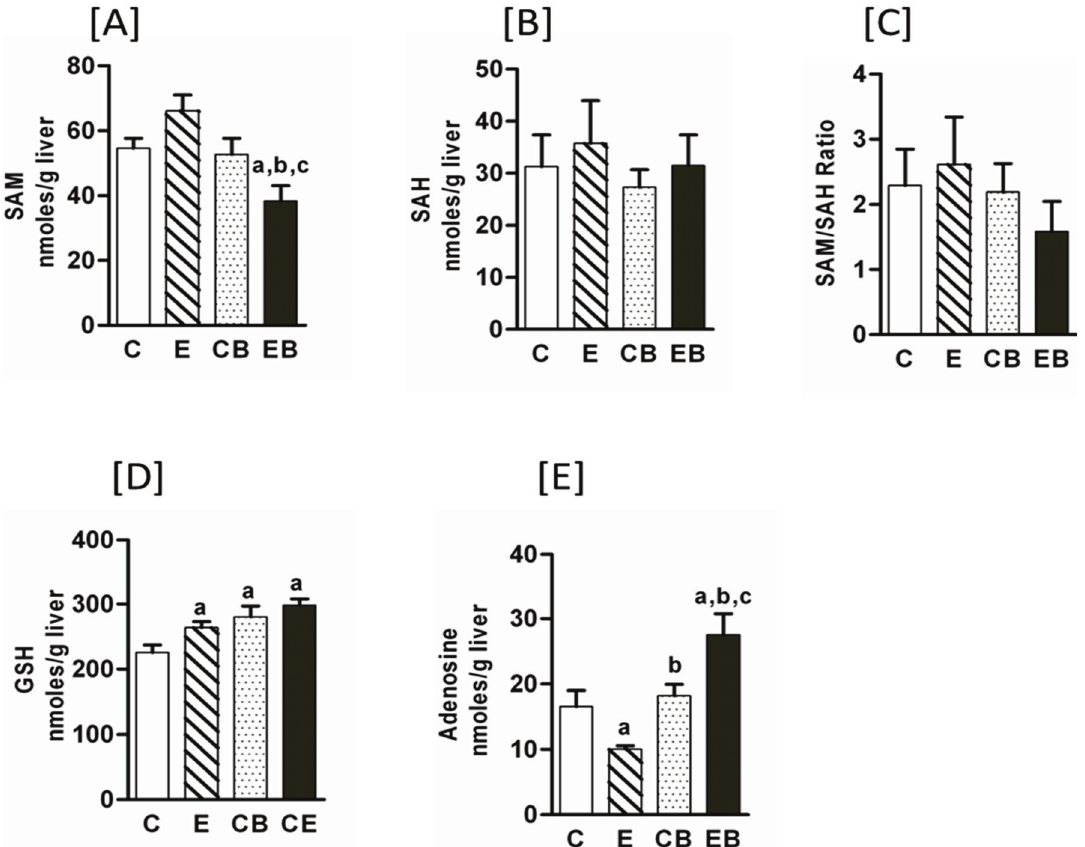
Figure 2. Hepatic s -adenosylmethionine (SAM), s -adenosyl homocysteine (SAH), adenosine and glutathione levels in chronic ethanol and binge treated mice. Experimental protocol was similar to that described in “Experimental Section”. Values are mean ± SE ( n = 4